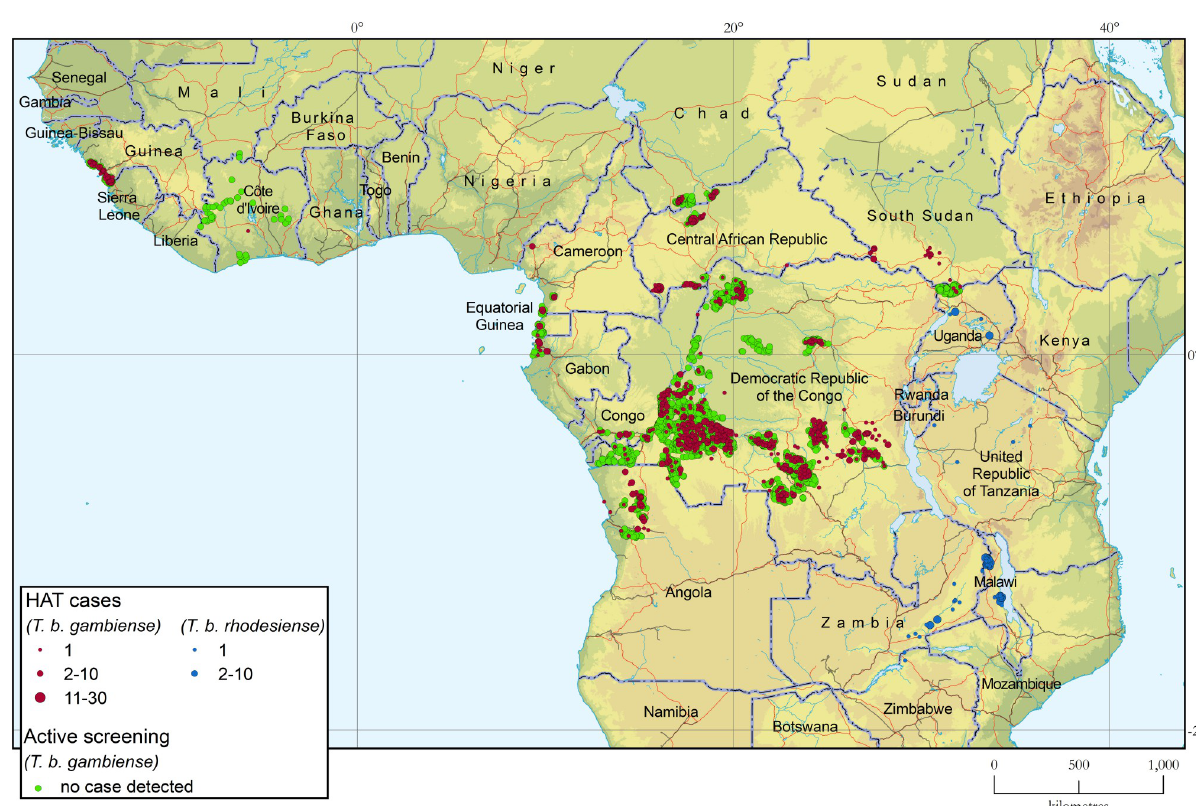
Fig 2. Geographical distribution of human African trypanosomiasis. Period 2019–2020. The base layers used in this map are the FAO Global Administrative Unit Layers (GAUL), Shuttle Radar Topography Mission (SRTM), FAO Inland water bodies in Africa, FAO Rivers of Africa and Vector Map Level 0